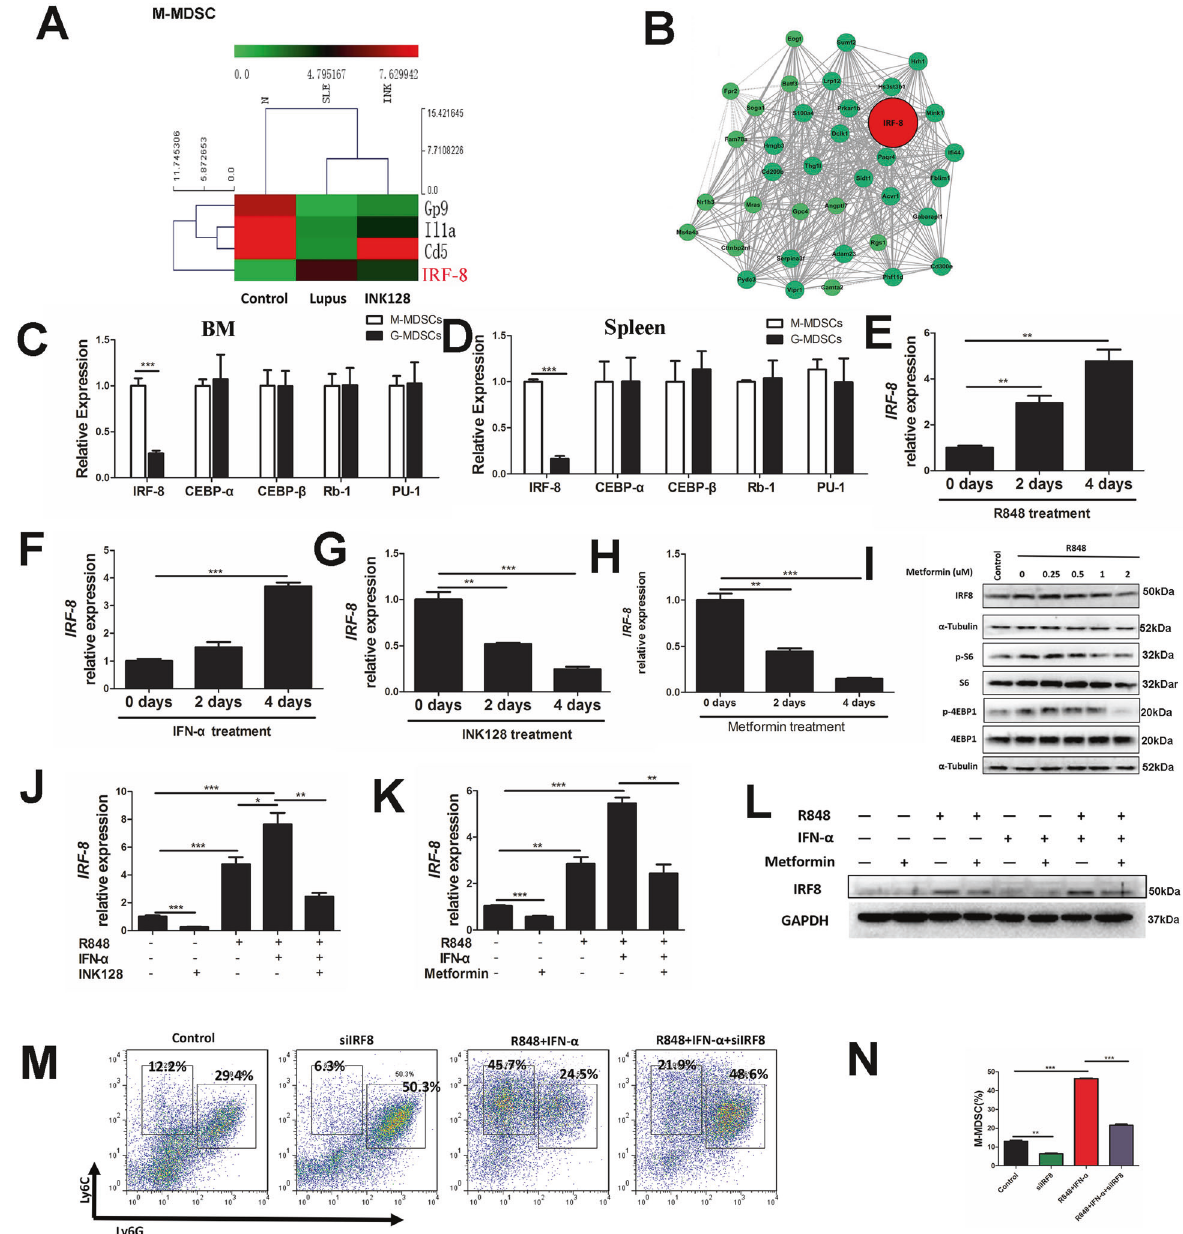
Fig. 5 The transcription factor IRF-8 is crucial for M-MDSCs differentiation. After the Pristane-induced lupus mouse model was established, G-MDSCs and M-MDSCs were puri fi ed from Spleen-derived MDSCs mice using myeloid-derived suppressor cell isolation kit. Then, the whole- genome transcriptome pro fi ling were performed by RNA sequencing. A The differential mRNA expression of hematopoietic cell lineage pathway in M-MDSCs between lupus mice and control mice are shown. B The relationship of IRF-8 with the differential mRNA expression in M- MDSCs are shown in Co-expression network relation map. Relative quantitation of IRF-8, CEBP- β , CEBP- α , Rb1 , and PU1 gene expressions by RT- PCR in between G-MDSCs and M-MDSCs in BM ( C ) and spleen ( D ) from lupus mice. Relative quantitation of IRF-8 in BM cells treated with R848 ( E ), IFN- α ( F ), INK128 ( G ), and Metformin ( H ) in 0, 2, 4 d. I BM cells treated with 100 ng/ml R848 and different concentration of Metformin were at the same time. The expression of p-4EBP, 4EBP1, p-S6 and S6 was detected by western blot. J Relative quantitation of IRF-8 in BM cells treated with R848, IFN- α or INK128 for 4 days. K Relative quantitation of IRF-8 in BM cells treated with R848, IFN- α or Metformin for 4 days. L Mouse BM cells were cultured for 4 days in GM-CSF and IL-6 with or without Metformin, R848 and IFN- α . The expression of IRF-8 was detected by western blot. M Mouse BM cells were cultured for 4 days in GM-CSF and IL-6 with or without Metformin, R848 and IFN- α . The proportions of M-MDSCs were analyzed by fl ow cytometry. Results were expressed as mean ± SD of three independent experiments. * P ≤ 0.05, ** P ≤ 0.01, *** P ≤ supplemented with 40 ng/mL IL-6 and 40 ng/mL GM-CSF for by the expression of miR-451a, whereas the activity of the wild-type 4 days. At the same time, miR-NC, miR-451a, anti-miR-451a, and reporter gene was markedly reduced (Fig. 6H). anti-miR-NC were added to the culture in a single or mixed To identify whether miR-451a was essential for the differentia- manner. Anti-miR-451a was found to promote the differentiation tion of M-MDSCs, BM cells were cultured in a medium